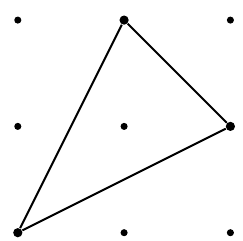
Figure 3. The toric diagram of the C 3 = Z 3